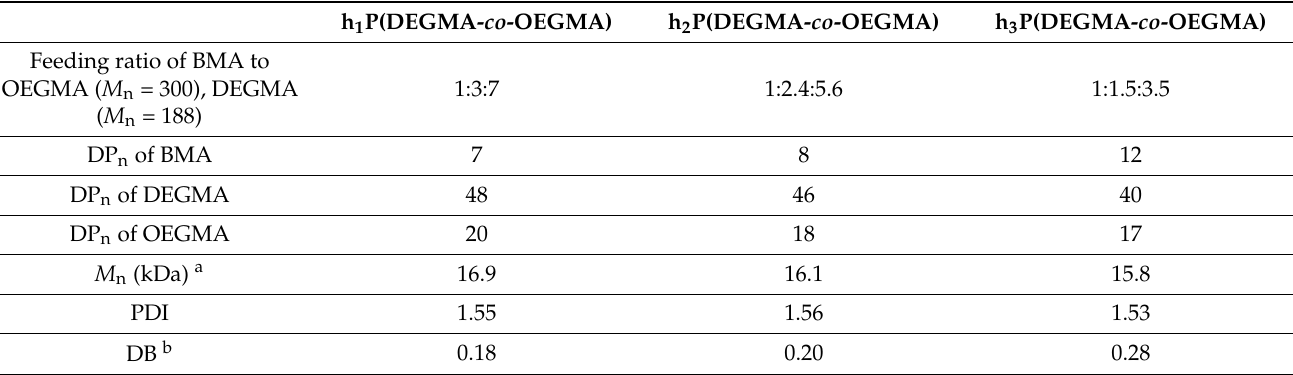
Table 3. Structure data of the three hyperbranched